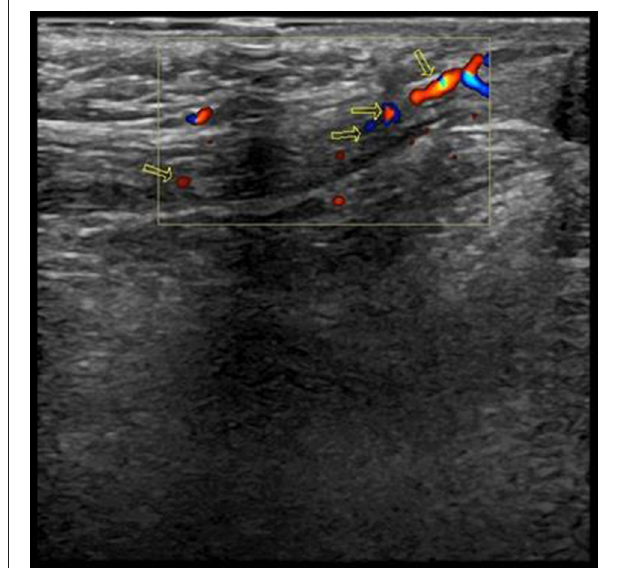
FIGURE 1 | Normal long-axis section of spermatic cord (Yellow arrows point to hypoechoic cremaster muscles).